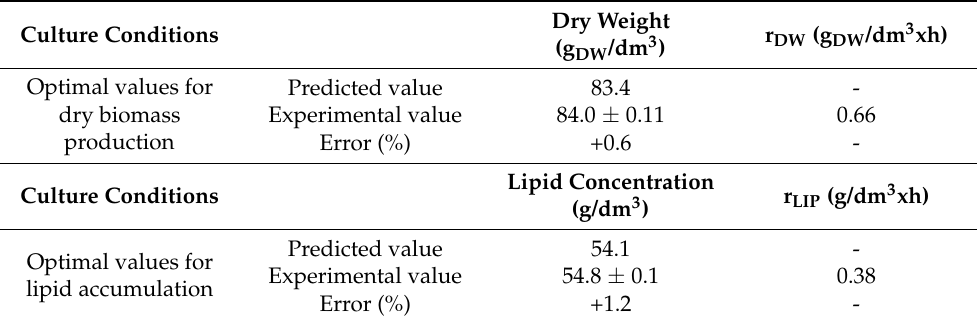
Table 11. Comparison of experimental data with the values predicted by the CCD mathematical mode.